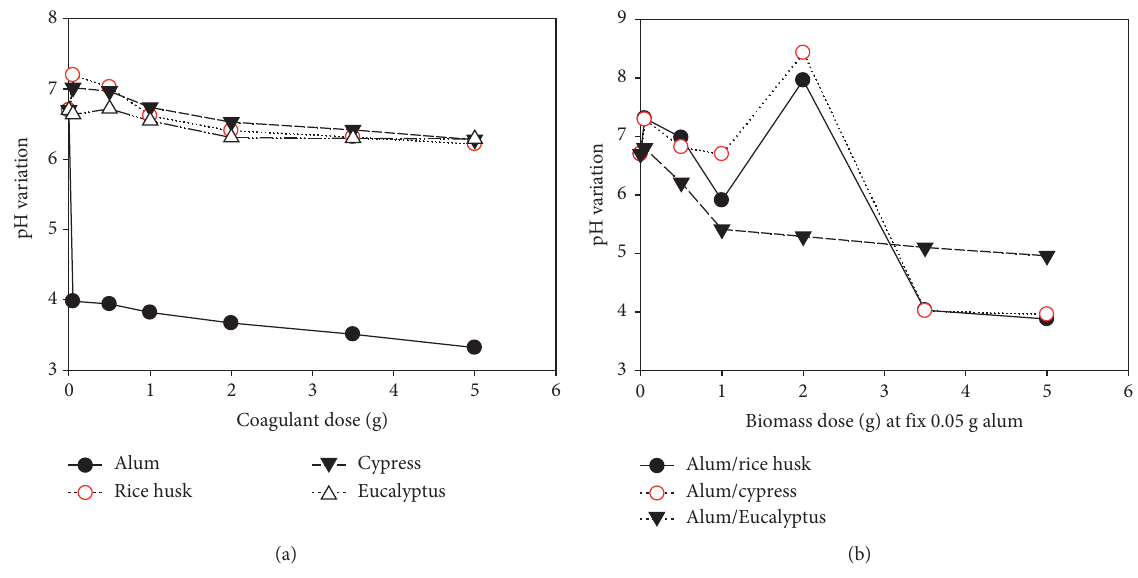
Figure 11: BSW variation of pH in BSW water with (a) individual coagulants and (b) mixed